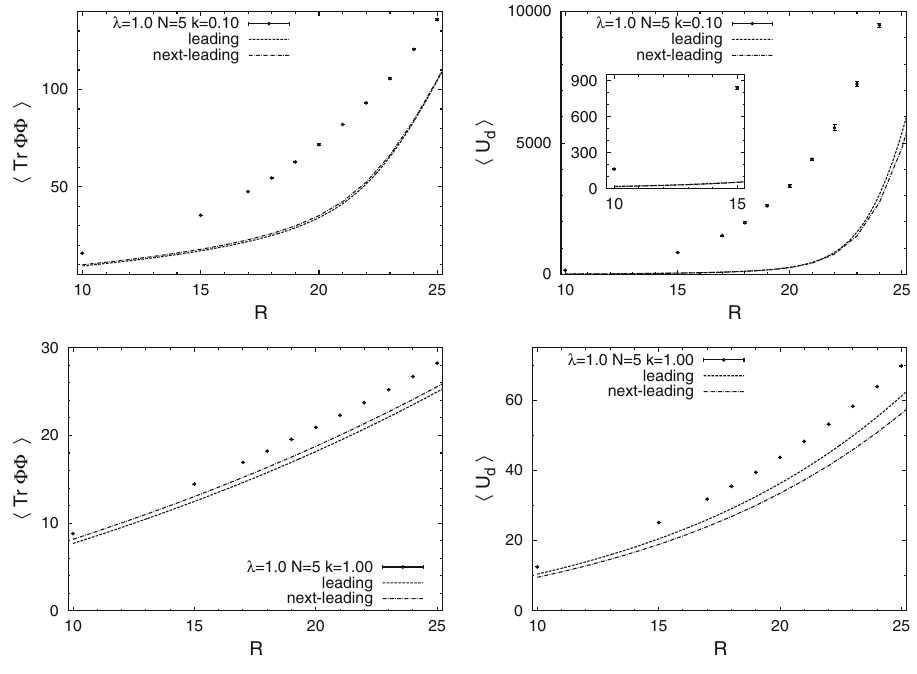
chained lines represent the values of the e.v. of the observ- ables in the leading and the next-leading orders by adopt- ( t ) leading / next − leading to (12), respectively. ing f N , R ,λ,λ d